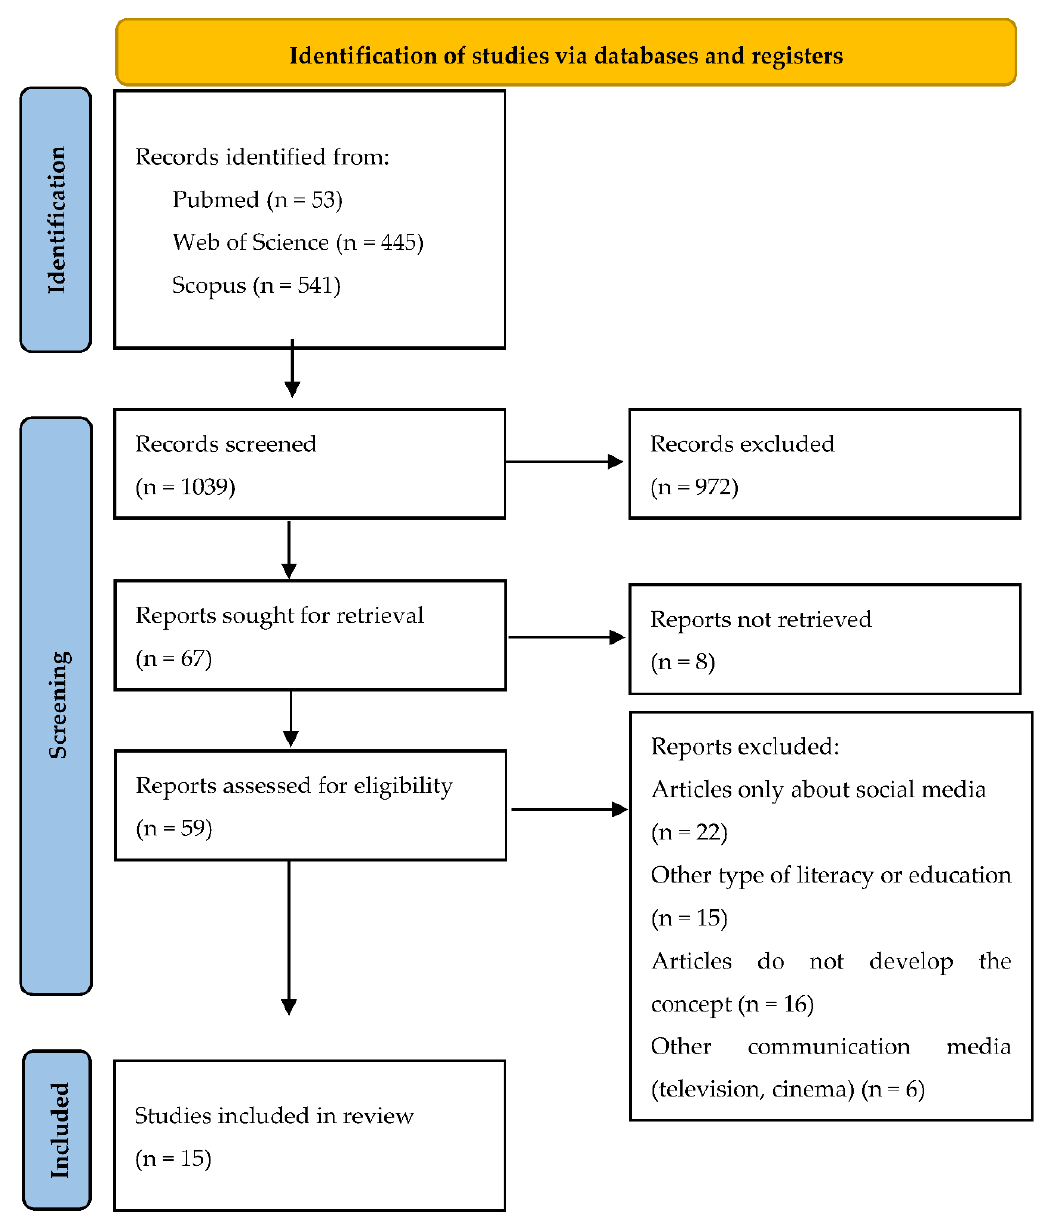
Figure 1. Systematic review flowchart (Adapted from Page et al., 2020 [49]).